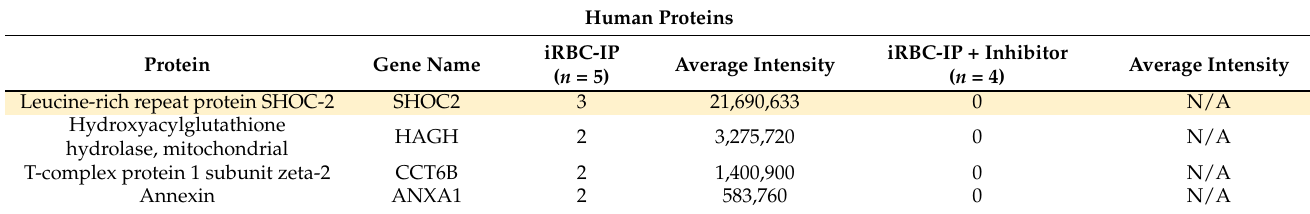
Table 3. BCL-x L binding partners identified in iRBCs. Mass spectrometry analysis of BCL-x L immunoprecipitates from iRBCs over a minimum of four independent biological replicates for each condition (iRBC-IP n = 4, iRBC-IP with inhibitor n = 5). The number of replicates in which the protein was identified is indicated, along with its relative average